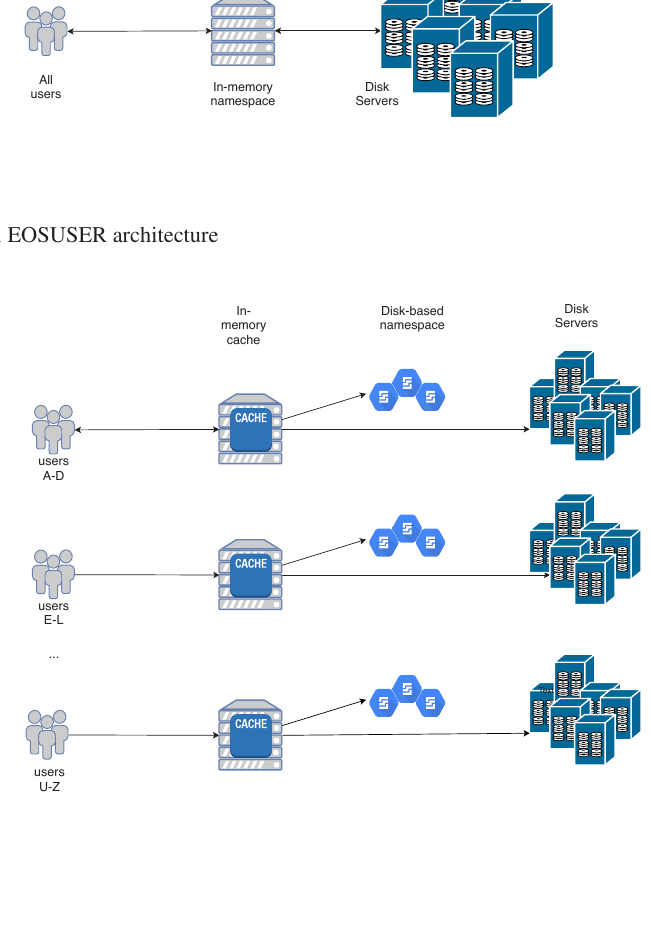
Figure 4. Total number of files by year Figure 5. Total used raw volume by year